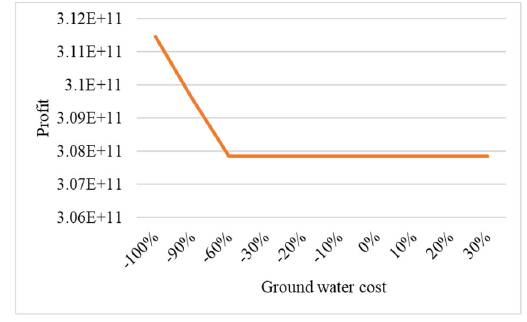
Fig. 8. Total profit vs. surface water cost Fig. 7. Total profit vs. groundwater